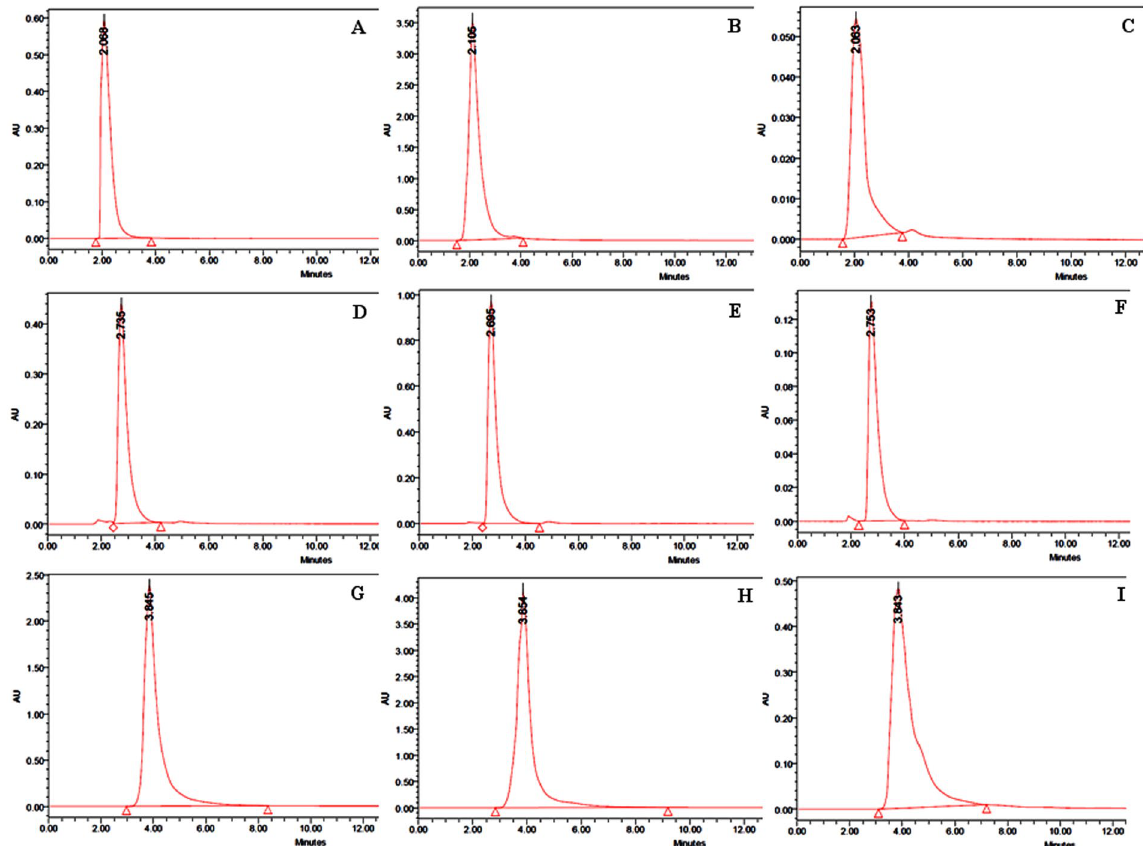
Figure 4. HPLC chromatogram representing the differential concentrations (maximum and minimum level) reported from toxigenic isolates of Alternaria . ( A ) standard chromatogram for TeA, ( B ) maximum conc. of TeA as recorded form isolate TM 4, ( C ) minimum conc. of TeA as recorded from isolate PE 1, ( D ) standard chromatogram for AOH, ( E ) maximum conc. of AOH from isolate TM 4, ( F ) maximum conc. of AOH from isolate ON 1, ( G ) standard chromatogram for AME, ( H ) maximum conc. of AME from isolate TM 4, and ( I ) minimum conc. of AME from BJ 6. Note: The names of the Alternaria isolates were given as abbreviation of the different plants from which they were isolated (details described in Table